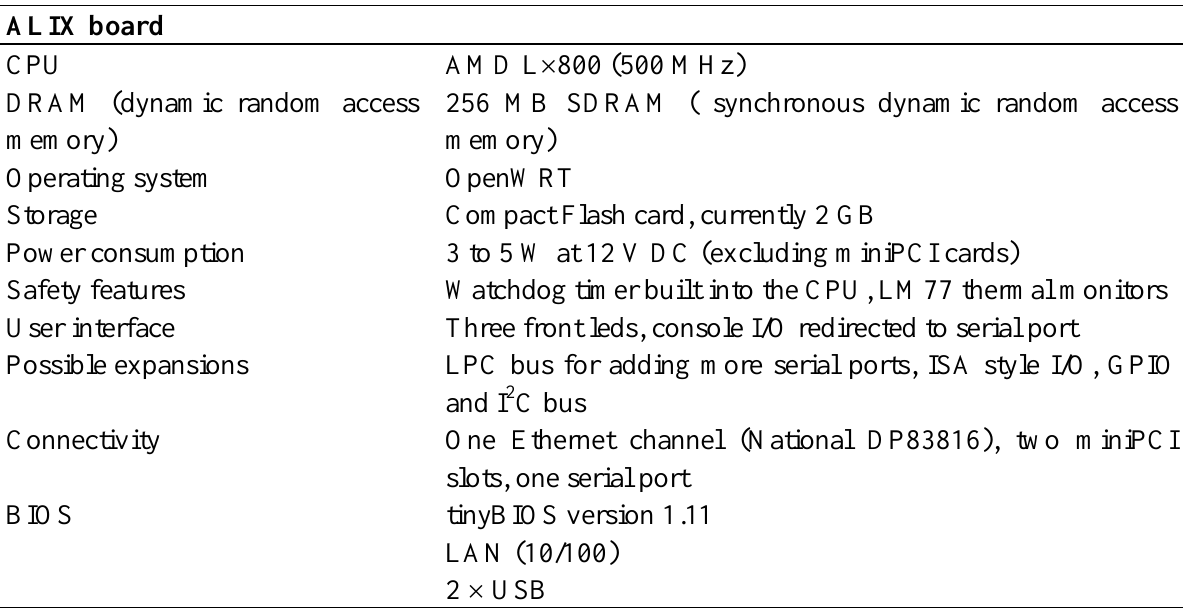
Table 2. Technical specifications of the various components that make up the ALIX board as currently used in the Wireless Sensing Units.